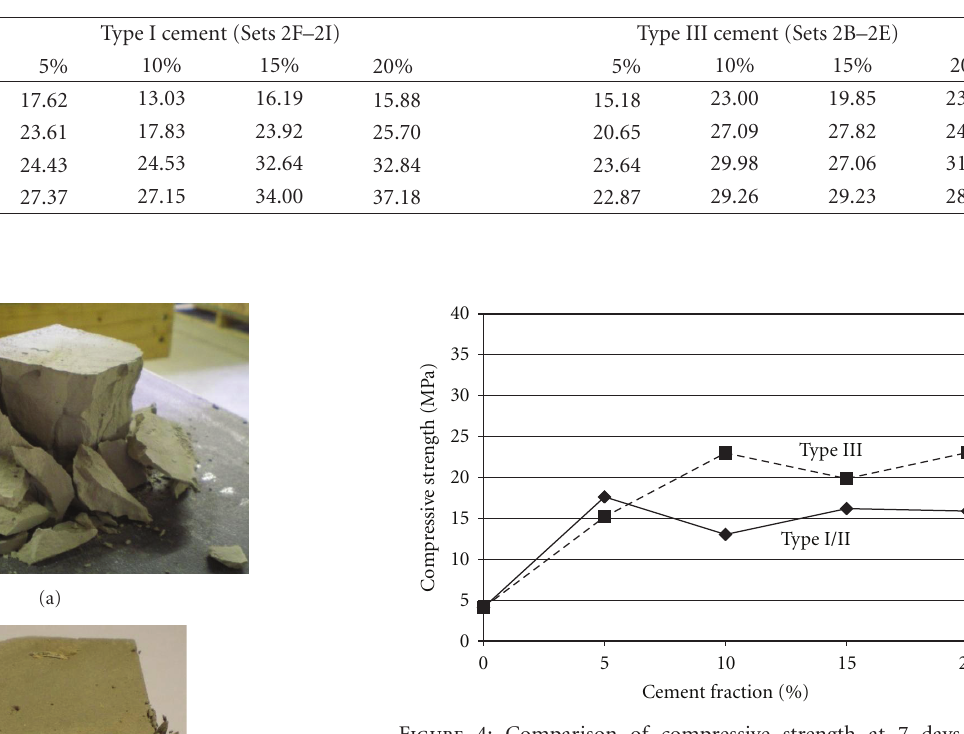
Table 4: Compressive strength for di ff erent types of cement, testing ages and percents of cement added (MPa).